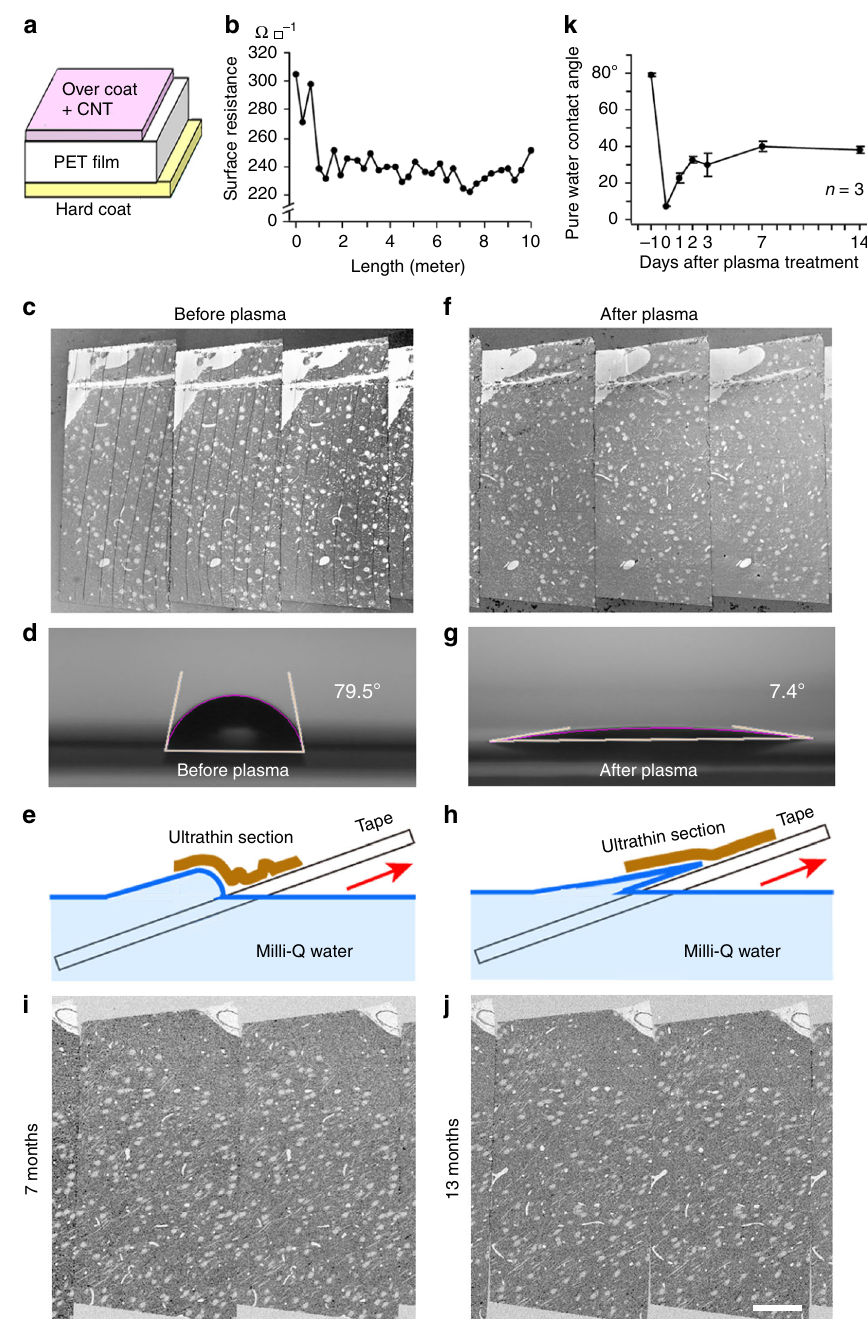
Fig. 1 Plasma glow discharge treatment prevents the generation of copious wrinkles on the sections collected on CNT tape. a CNT-coated PET tape consists of three layers. The middle layer is a 50 µ m-thick core structure made of PET fi lm. CNTs are buried in the over coat layer (2 µ m-thick). A hard coat layer (2 µ m-thick) is on the opposing side of the PET fi lm. Both coats are composed of a non-disclosed polymer. b Surface resistance of the CNT tape is uniform. c Ultrathin sections on the CNT-coated PET tape show many wrinkles. d PWCA of the CNT tape is 79.5 degrees. e Possible mechanism of the plasma treatment effect on the collection of the ultrathin sections for the untreated tape with the steep PWCA may cause dif fi culty in section landing. f Ultrathin sections on the CNT-coated PET tape with plasma treatment show no wrinkles. g PWCA of the CNT-coated PET tape after the plasma discharge treatment becomes 7.4 degrees, which shows that the tape is very hydrophilic. h The shallow PWCA promotes a smooth landing of the ultrathin sections on the plasma-treated tape from the water surface. i , j The plasma treatment effect for no wrinkle generation lasts for 7 months ( i ) and 13 months ( j ). Scale, 100 µ m. k Time course of the plasma treatment effect on the CNT-coated tape indicated by PWCA. Error bars denote SD. Scale in j is for c , f ,